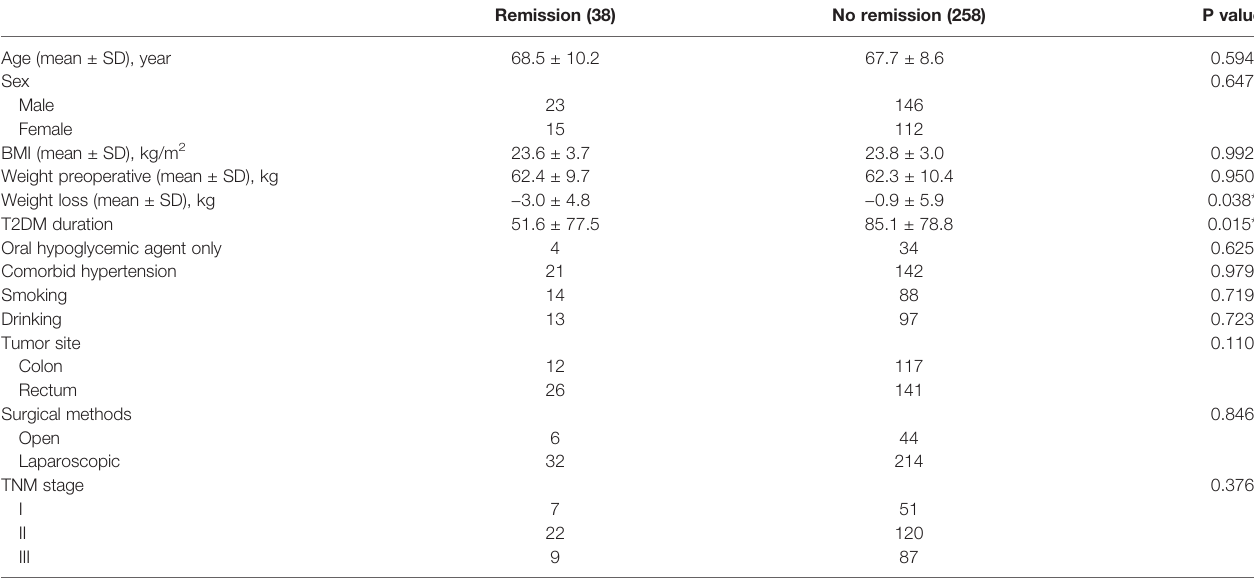
Variables are expressed as the mean ± SD or n (%), *P-value < 0.05. BMI, body mass index, T2DM, type 2diabetes mellitus; TNM, Tumor Node Metastasis.